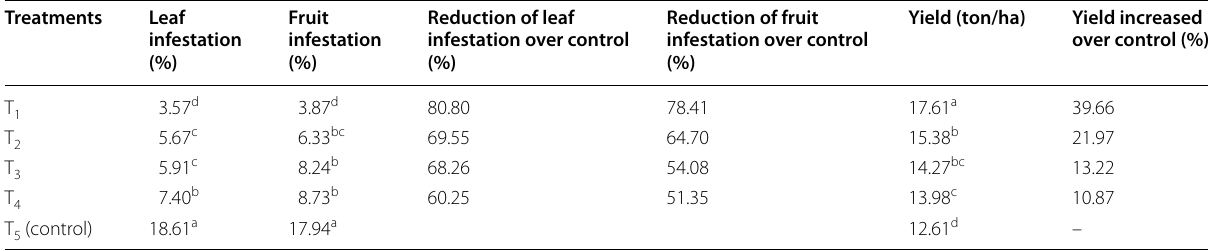
Table 7 Efficacy of different pest management modules on leaf and fruit infestation by hog-plum beetle, P. 14-punctata under field condition during